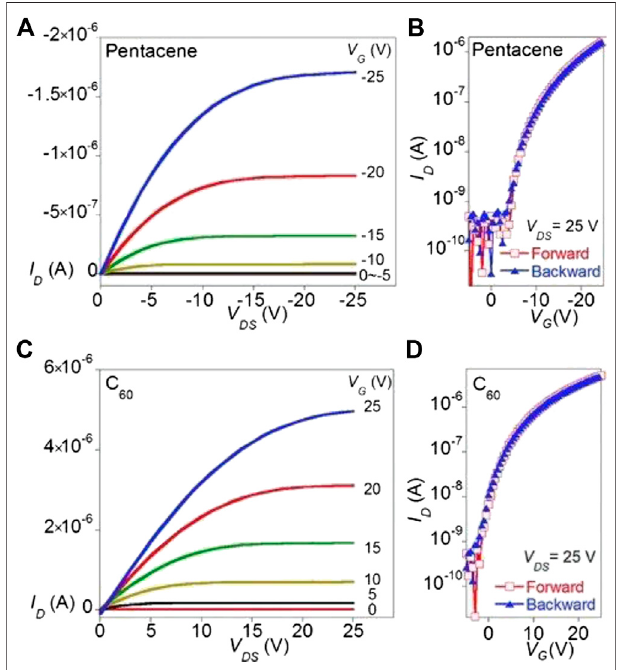
FIGURE 1 | The electrical properties of FETs with albumen dielectrics (Chang et al., 2011). Reproduced with permission.